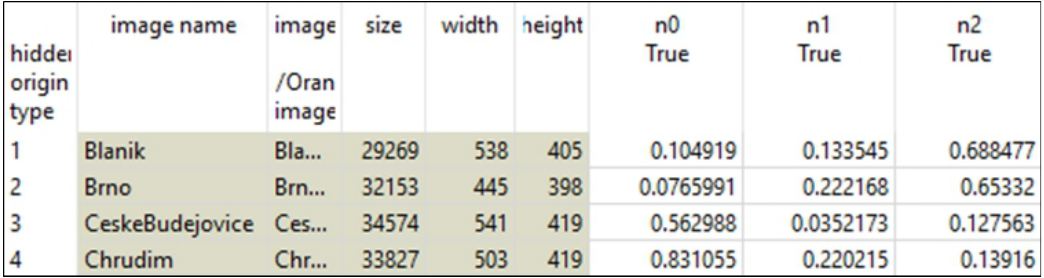
Figure 2. Table of enhanced output data with image descriptors (attributes n0 , n1 , n2 …) for each source image processed using the Image Analytics widget (only partial extract of descriptors).